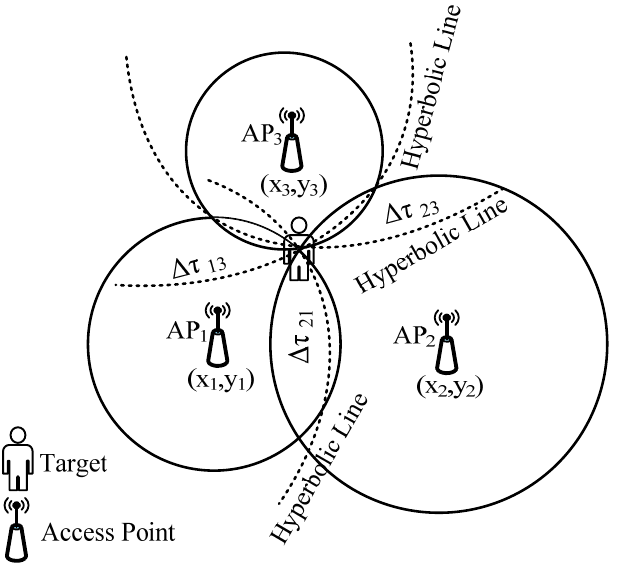
Figure 4. TDOA ‐ based trilateration. Figure 4. TDOA-based